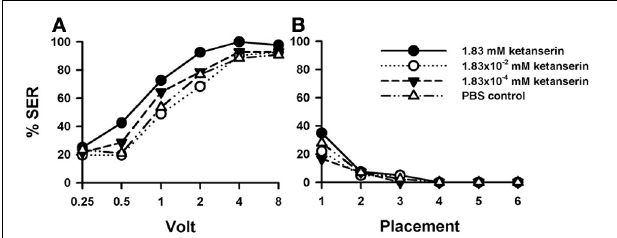
FIGURE 6 | Effects of 5-HT blocking on aversive responsiveness. (A,B) Three different groups of bees were injected with three different concentrations of the 5-HT antagonist ketanserin (1.83mM: n = 40; 1.83 × 10 − 2 mM: n = 41; 1.83 × 10 − 4 mM: n = 42). A fourth group was injected with PBS as a control ( n = 43). Sting responsiveness was measured in response to a series of increasing voltages during shock trials (A) and during placement trials (B) . Only the highest ketanserin concentration increased significantly shock responsiveness with respect to the control (1.83mM: p < 0 . 05) while the other two concentrations did not (1.83 × 10 − 2 mM and 1.83 × 10 − 4 mM: NS in both cases). No differences were detected in the placement